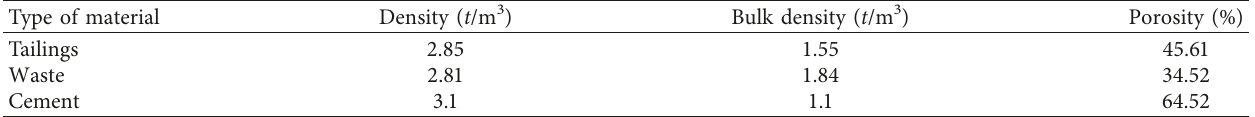
Table 1: Physical properties of the materials.